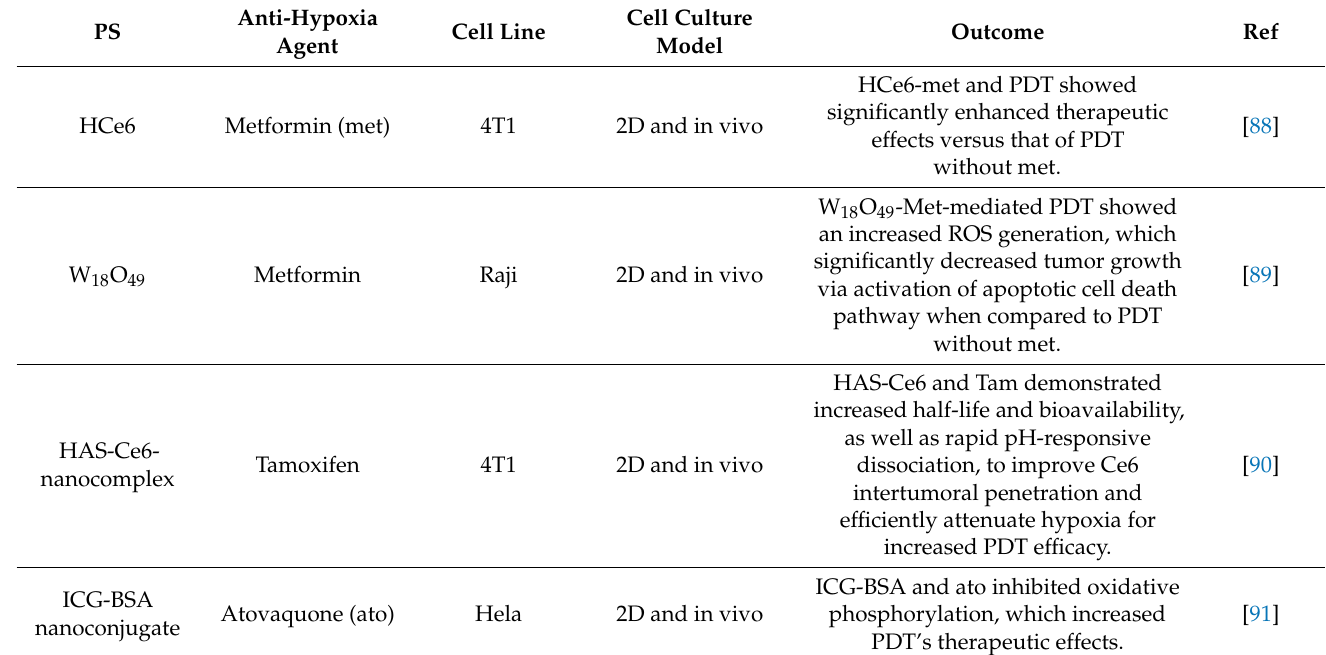
Table 5. Summary of studies that reduced O 2 consumption by modulating